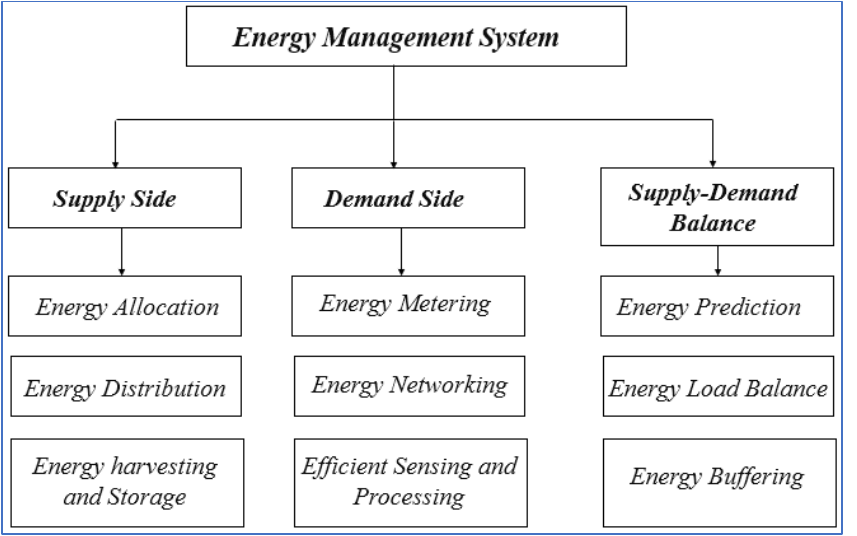
Figure 2. Energy management taxonomy.